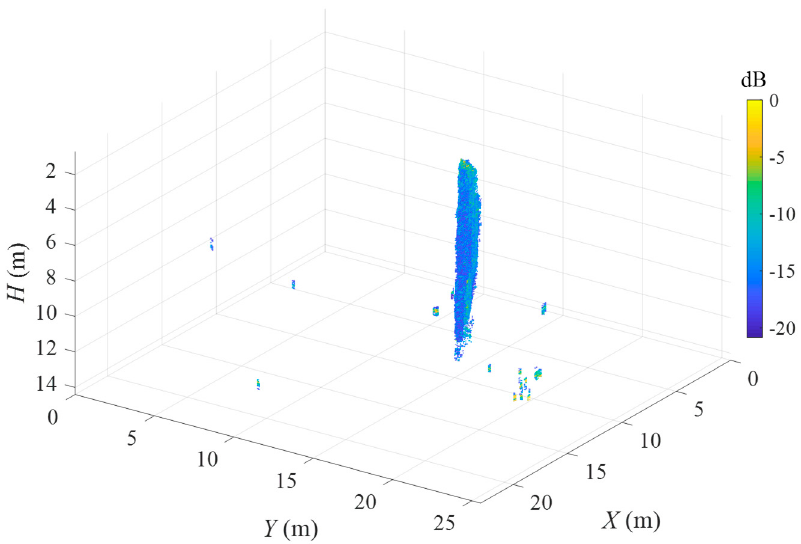
Figure 16. The result of the multi-threshold detection of WCI data measured on a short survey line in the Songhua Lake.